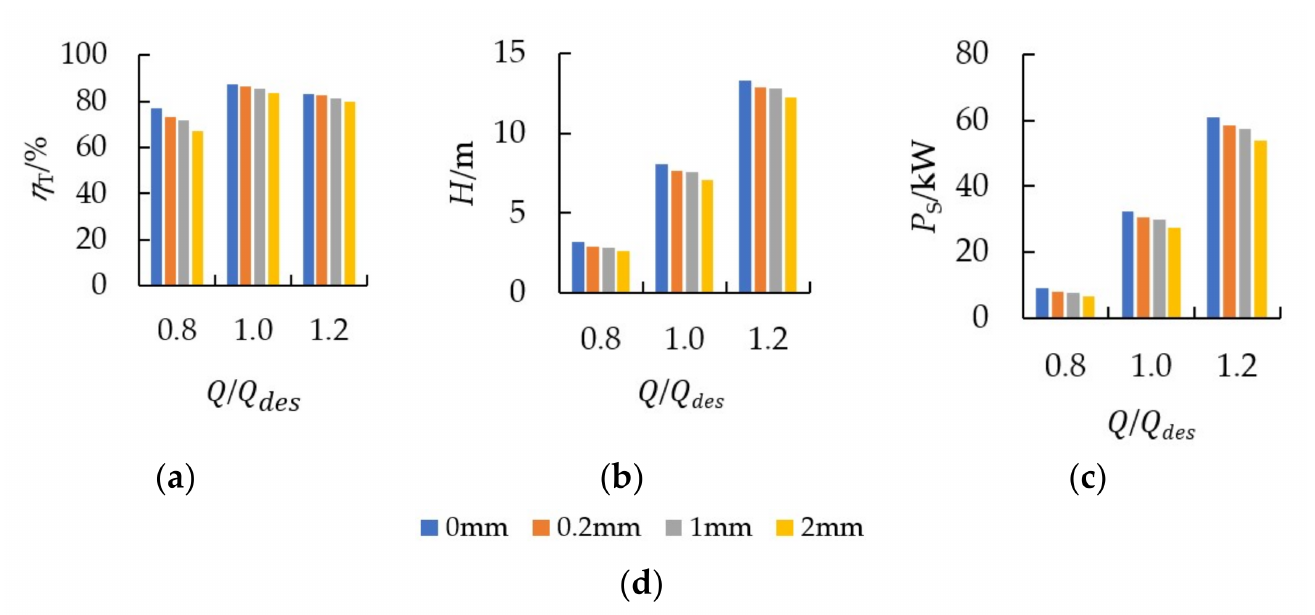
Figure 6. Comparison of ( a ) efficiency; ( b ) head; ( c ) shaft power under different tip clearances in turbine condition; ( d ) Legend.